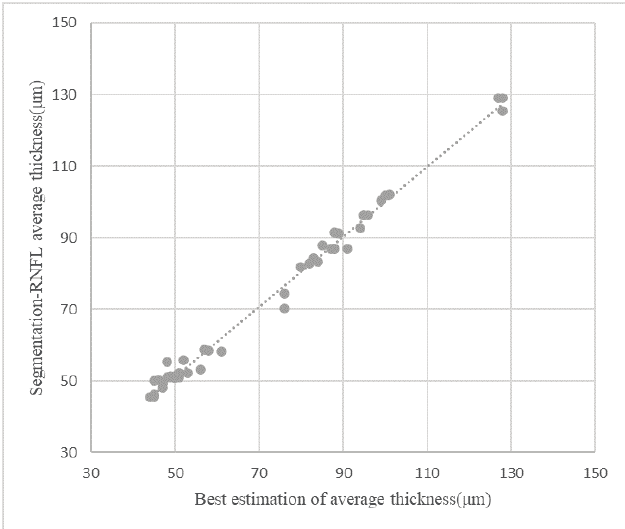
Figure 7. Scatterplot illustrating the relationship between the prediction thickness value and best estimation thickness measurement by the expert for the test